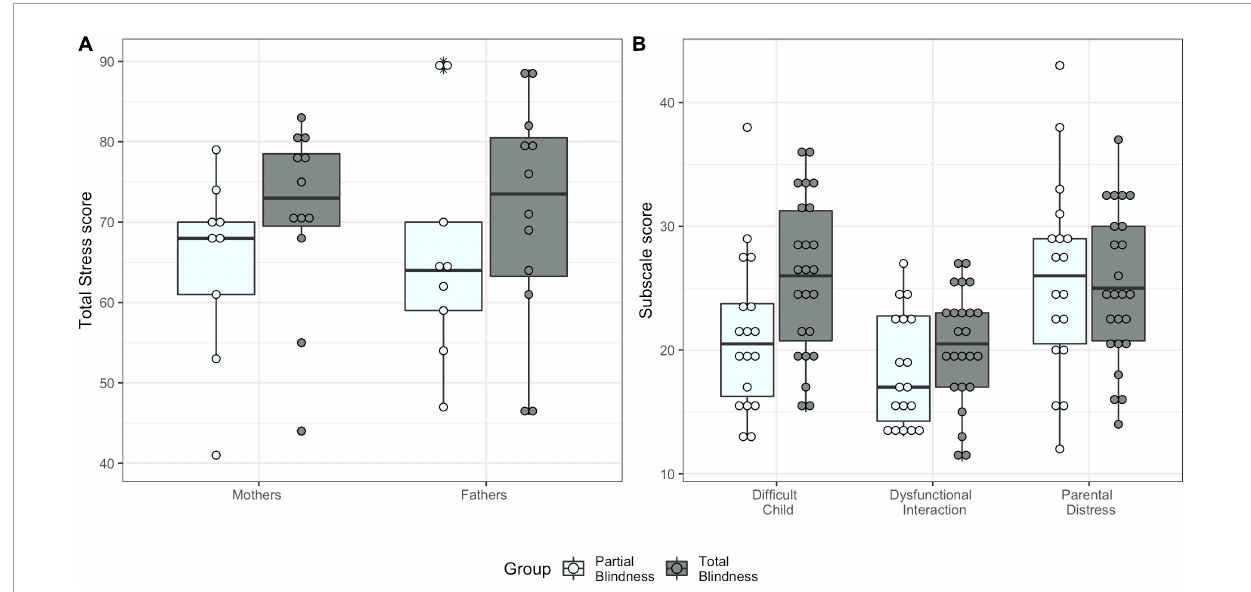
FIGURE1 Parenting stress index scores by blindness group. (A) Total Stress score for mothers and fathers. (B) Parental scores for the three subscales (Difficult Child, Parent-Child Dysfunctional Interaction, and Parental Distress).